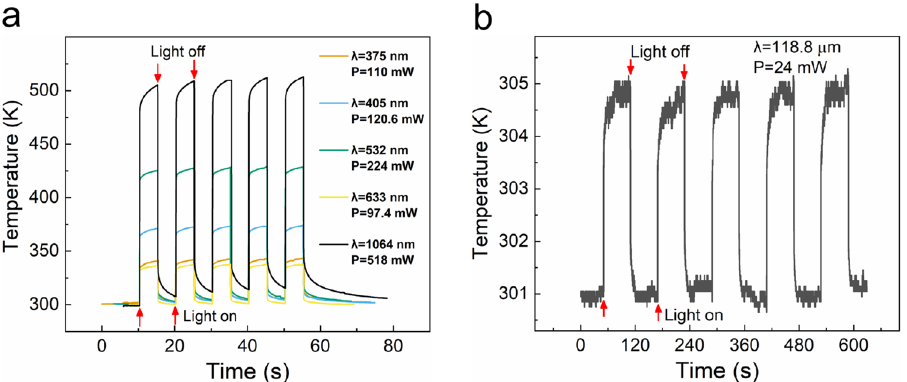
Fig. 2 Temperature – time curves. Photothermal response curves of the center temperature of the heterojunction with time when the heterojunction was irradiated by lasers with wavelengths of a 375 nm, 405 nm, 532 nm, 633 nm, 1064 nm, and b 118.8 μ